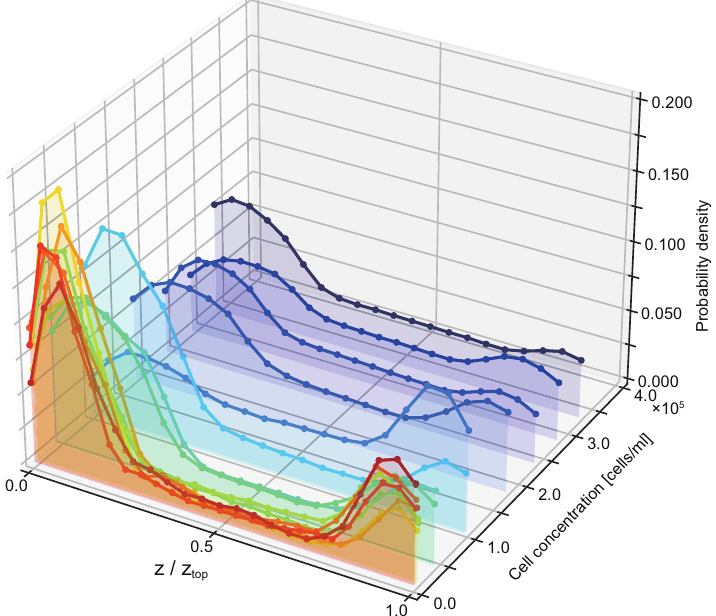
Figure 3. Probability density distribution of the cells as a function of relative z -position, z / z top , depending on cell concentration. For each plot line, the height axis is normalized with the height of the water from the bottom to the top surface, z top